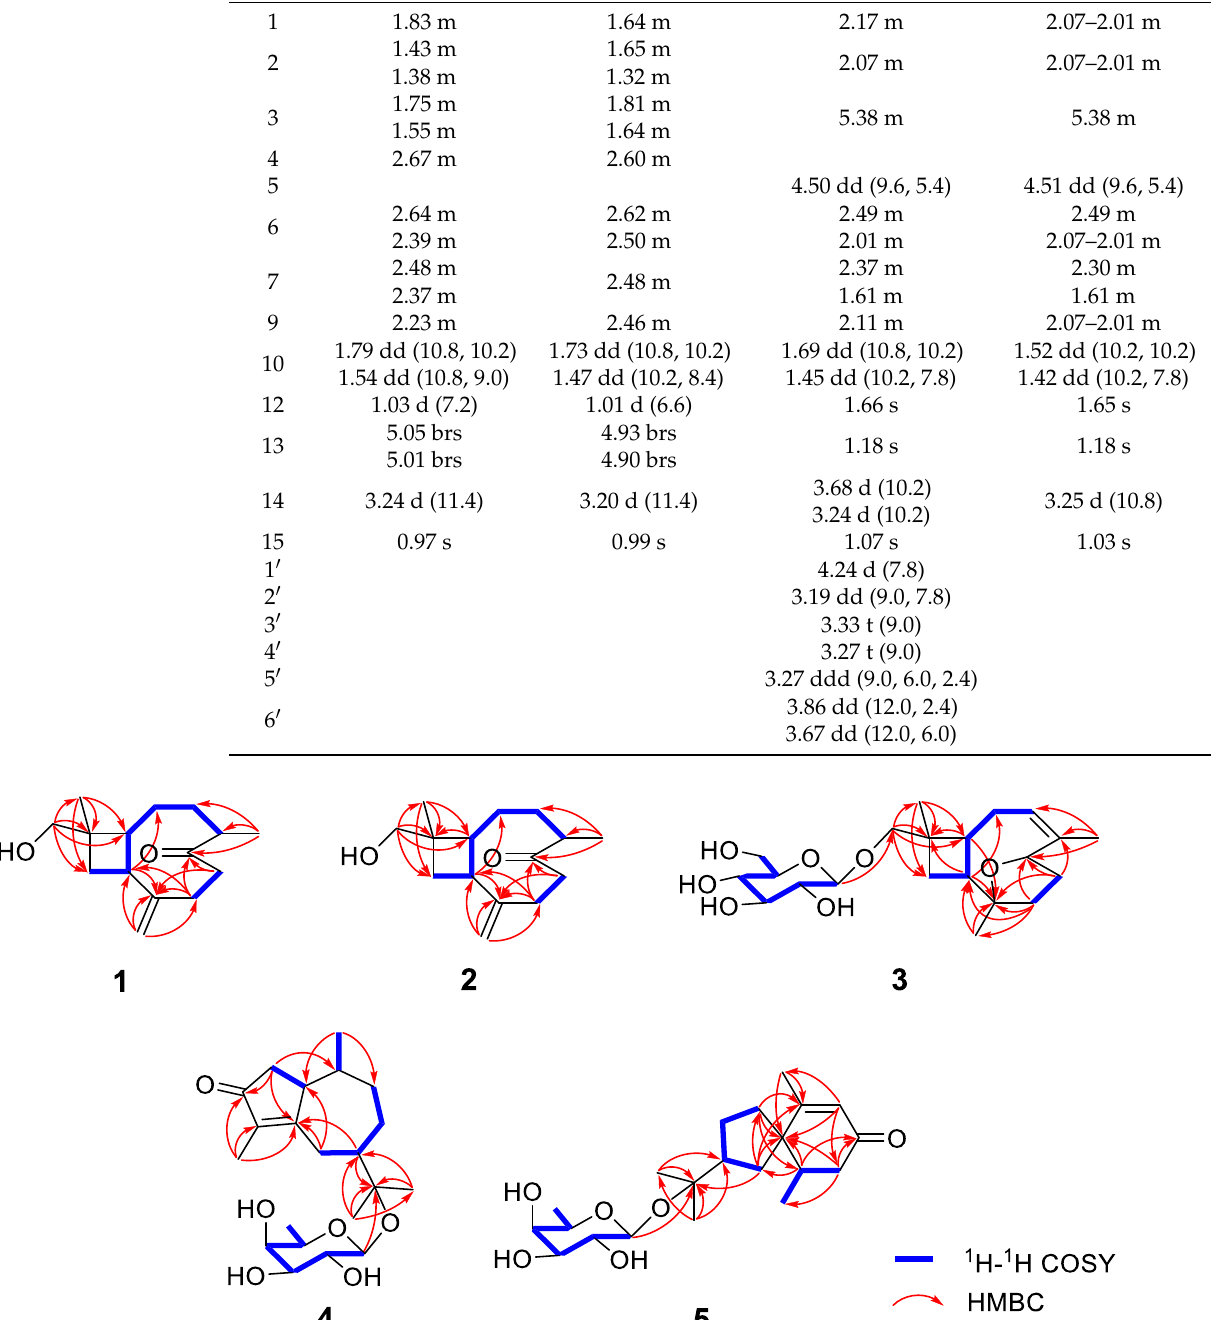
Figure 2. Key 1 H – 1 H COSY and HMBC correlations of compounds 1 – 5 . Figure 2. Key 1 H– 1 H COSY and HMBC correlations of compounds 1 – 5